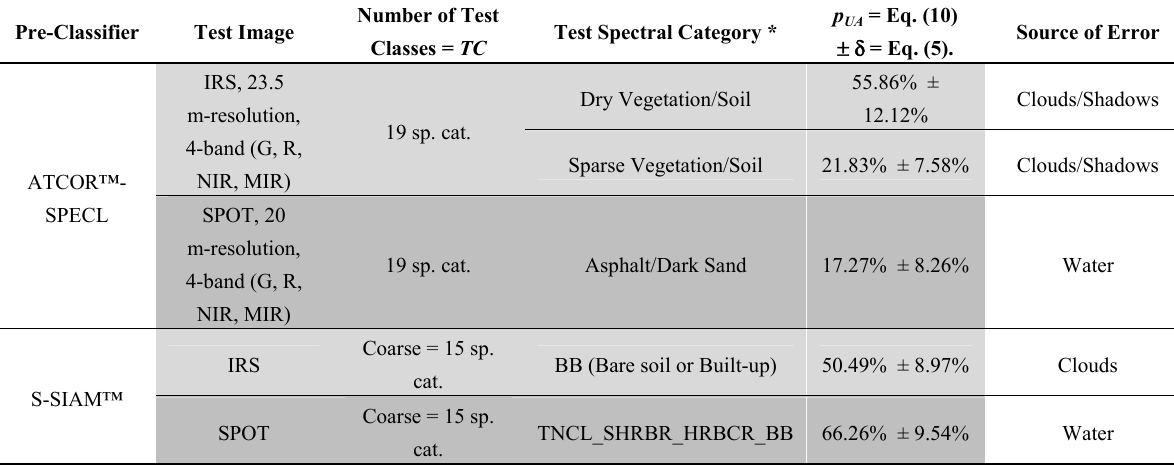
Table 17. Notable test spectral categories demonstrating low User’s Accuracy = (cid:1868) = Equation (10) ±δ = Equation (5) for the ATCOR™-SPECL and SIAM™ pre-classification maps of the three test images with α = TC /100, 1 − α / TC = 0.99, χ 2 = 6.63 in Equation (1, 1- α / TC )